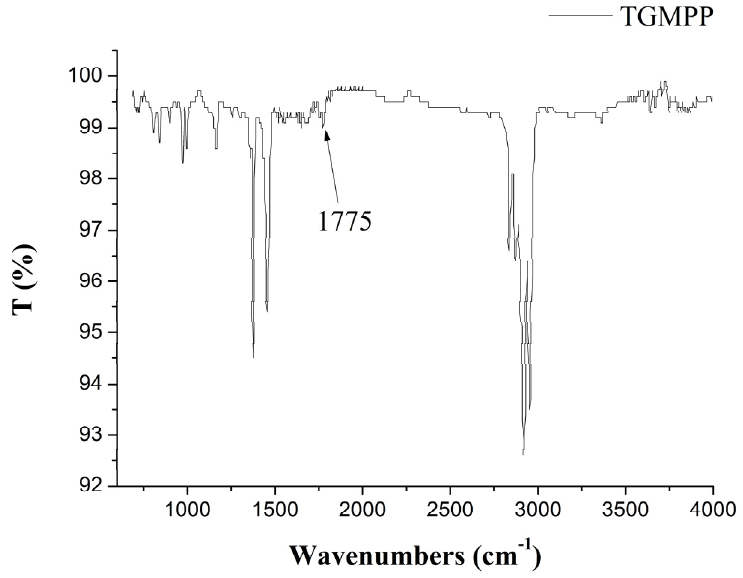
Figure 4. The infrared spectroscopy of